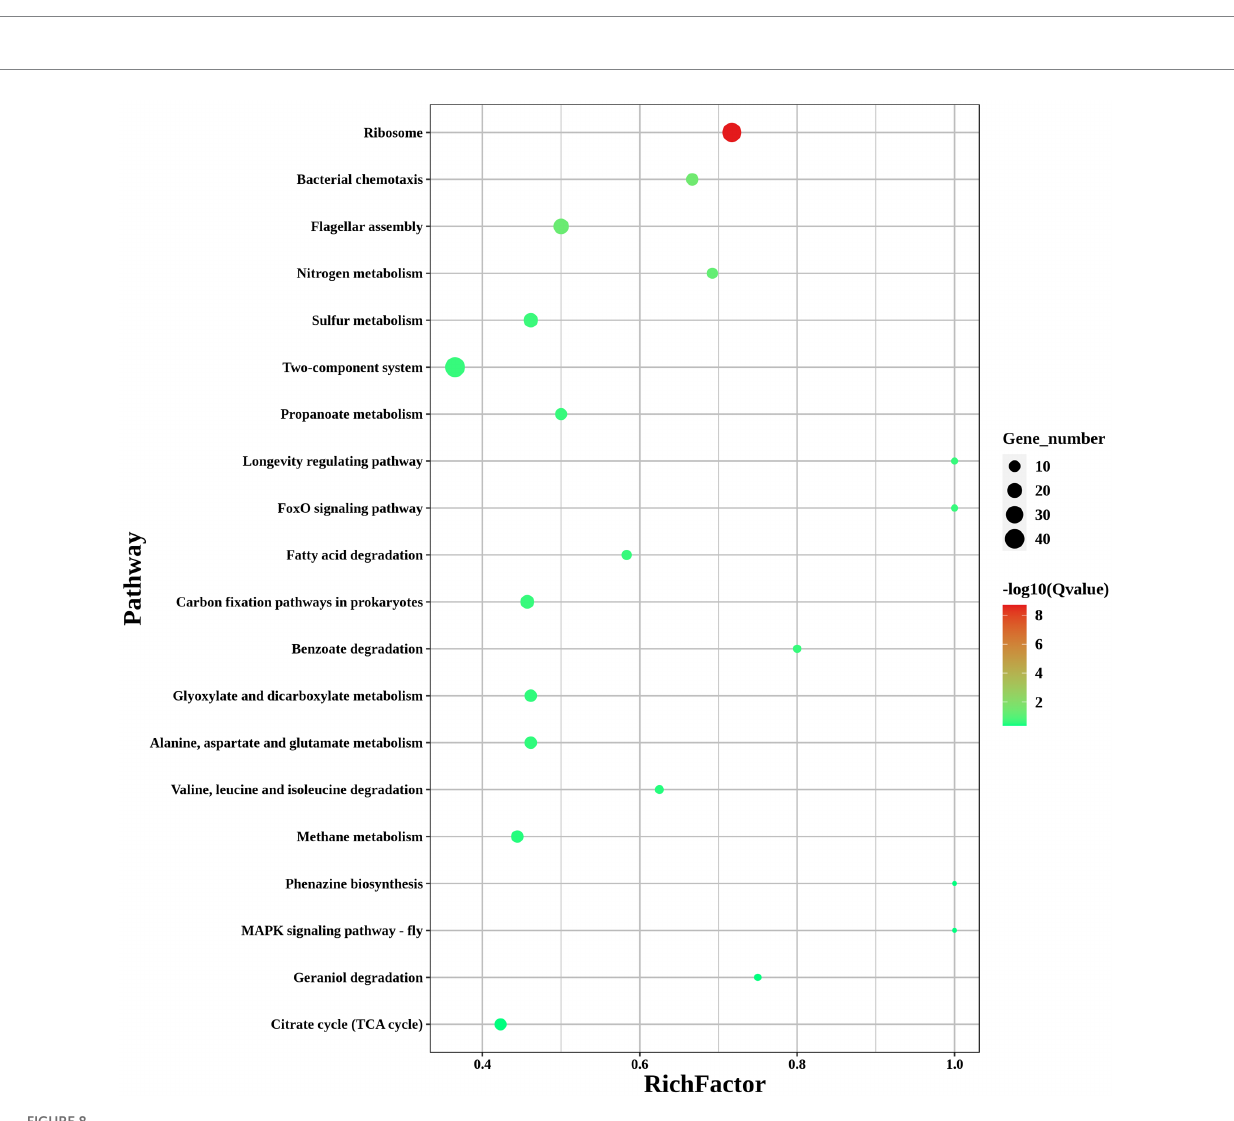
FIGURE 8 KEGG pathways of DEGs. KEGG enrichment scatterplot. The vertical axis shows the path name, sorted from smallest to largest q value; the horizontal axis shows-log10 ( q value); the sizes of the points indicate the numbers of DEGs in the pathways; the colors of the points correspond to different q value values. The greater the rich factor, the greater the enrichment. The range of the q value is [0, 1]; the closer to zero, the more significant the